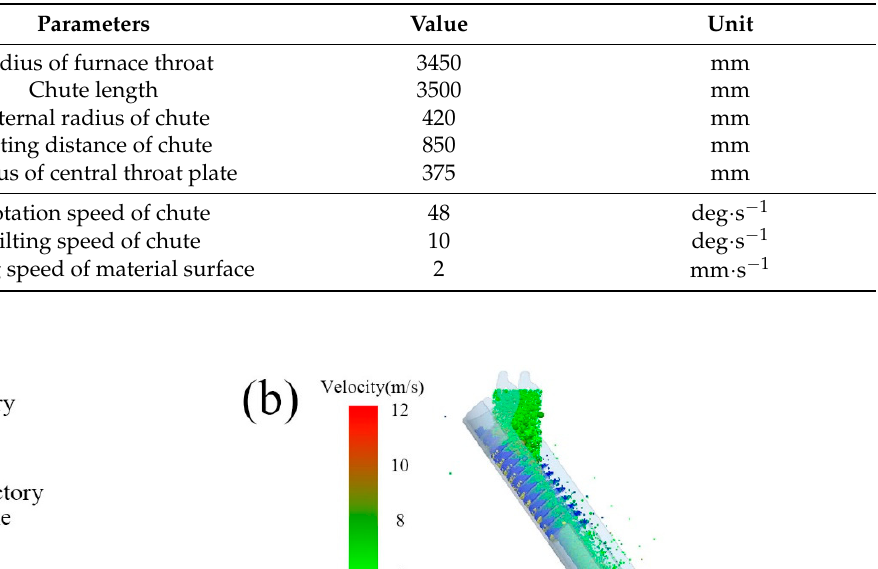
Figure 3. Schematic diagram of the parallel-hopper bell-less top. Table 6. Geometric model parameters of charging equipment.